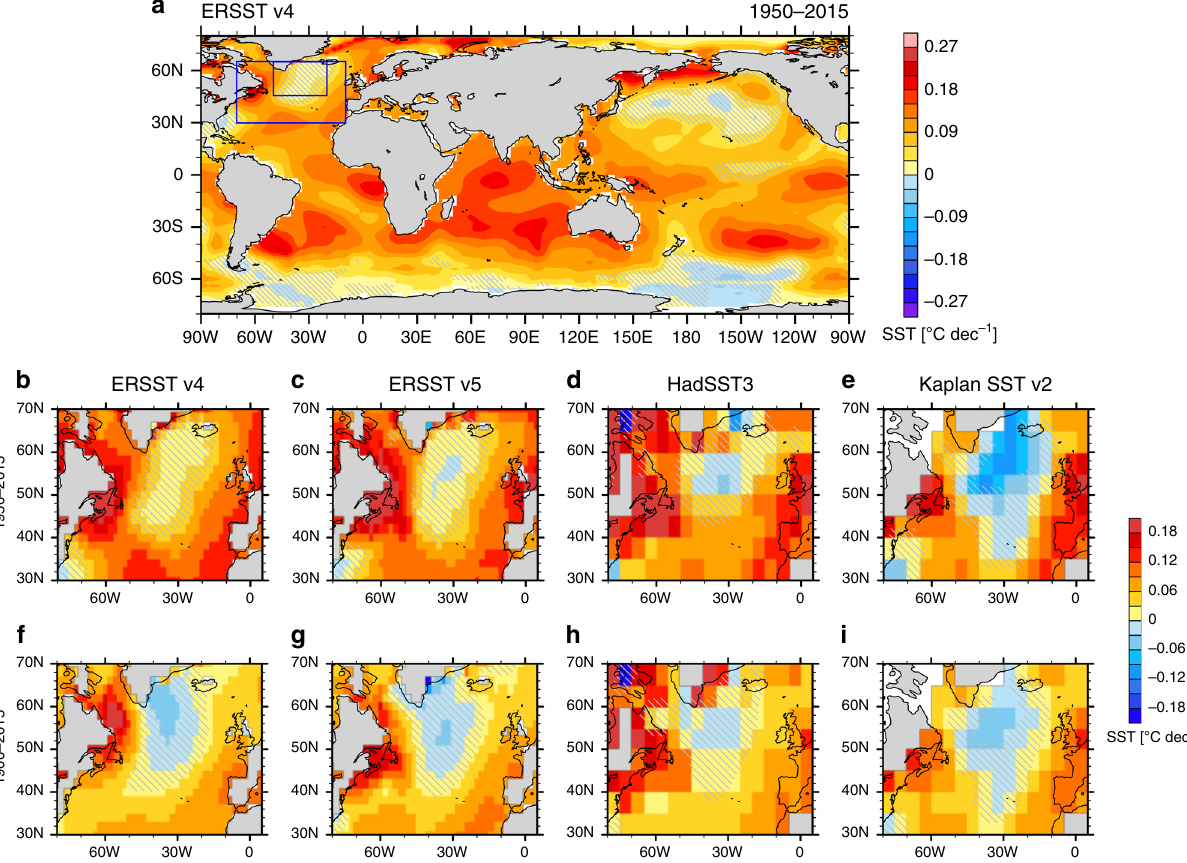
Fig. 1 Historical warming trends. a Global pattern of observed trends in annual-mean sea surface temperature (SST; units: °C/decade). The North Atlantic warming hole (NAWH) index is de fi ned as the difference between average SST for the two blue boxes. b – f As in panel ( a ) but focusing on the extratropical North Atlantic and using different datasets and time periods. Gray hatches highlight the areas of lower statistical signi fi cance ( p -values of Student ’ s t test above